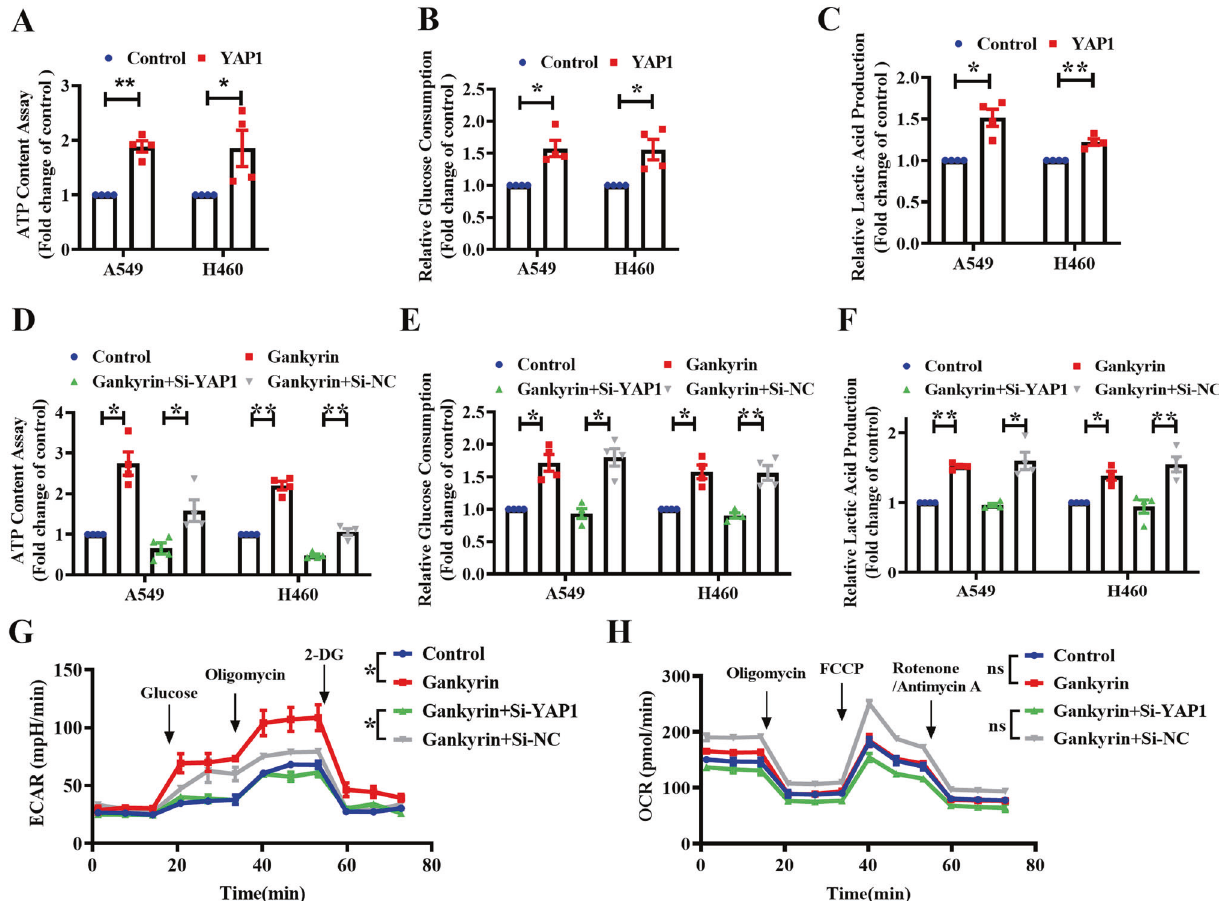
Fig. 6 Gankyrin promotes glycolysis through YAP1. Relative ATP content ( A , D ), glucose consumption ( B , E ), and lactic acid production ( C , F ) were determined in A549 and H460 cells transfected with YAP1-overexpression plasmid or with Gankyrin-overexpression plasmid and YAP1 siRNA or si-NC ( n = 4, * P < 0.05, ** P < 0.01). G ECAR was measured using a Seahorse Bioscience Extracellular Flux Analyzer after transfection with Gankyrin and si-YAP1 in A549 cells. ECAR curves were obtained after treatment with glucose, oligomycin, and 2-DG. Black arrows represent the time of cell treatment ( n = 3, * P < 0.05). H OCR was measured using Seahorse Bioscience Extracellular Flux Analyzer after transfecting A549 cells with Gankyrin and si-YAP1. OCR curves were obtained after treatment with oligomycin, FCCP, and rotenone/antimycin A. Black arrows indicate the time of treatment ( n = 3, ns means no signi fi